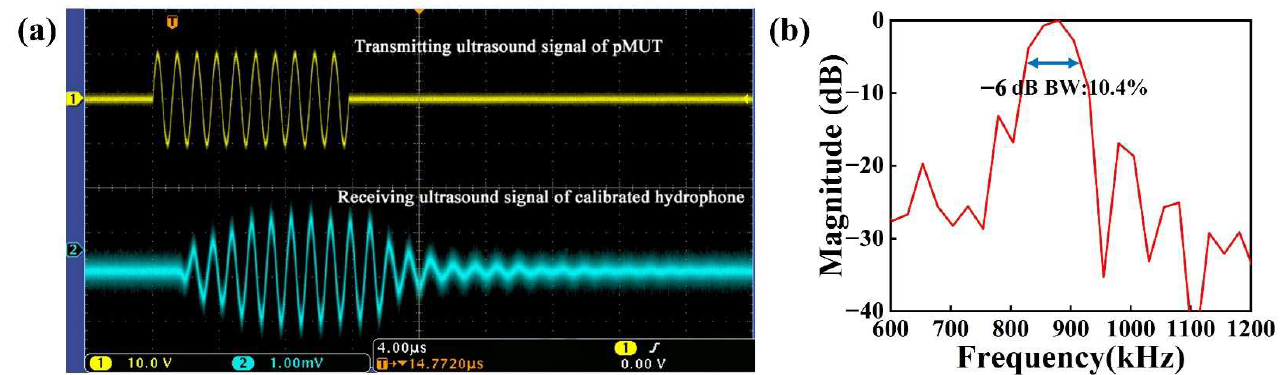
Figure 8. ( a ) Measurement results of transmitting sensitivity of a pMUT with an I-shaped diaphragm; ( b ) the frequency response of a pMUT with I-shaped diaphragm.